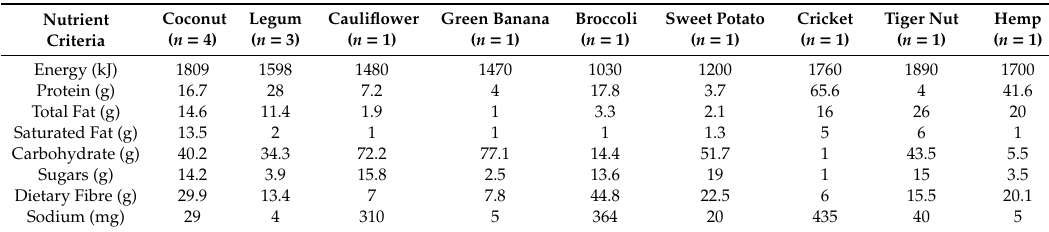
Table 5 ranks the frequency of front-of-pack claims in the flour category with ‘No artificial colours / flavours / preservatives’ the most common claim made on packaging, featuring on more than 1 / 3 of the total category. Gluten free was also featured on more than 25% of products, important for those needing to comply with therapeutic diets. Dietary fibre claims were also prevalent in this category, with just over 20% of products making this